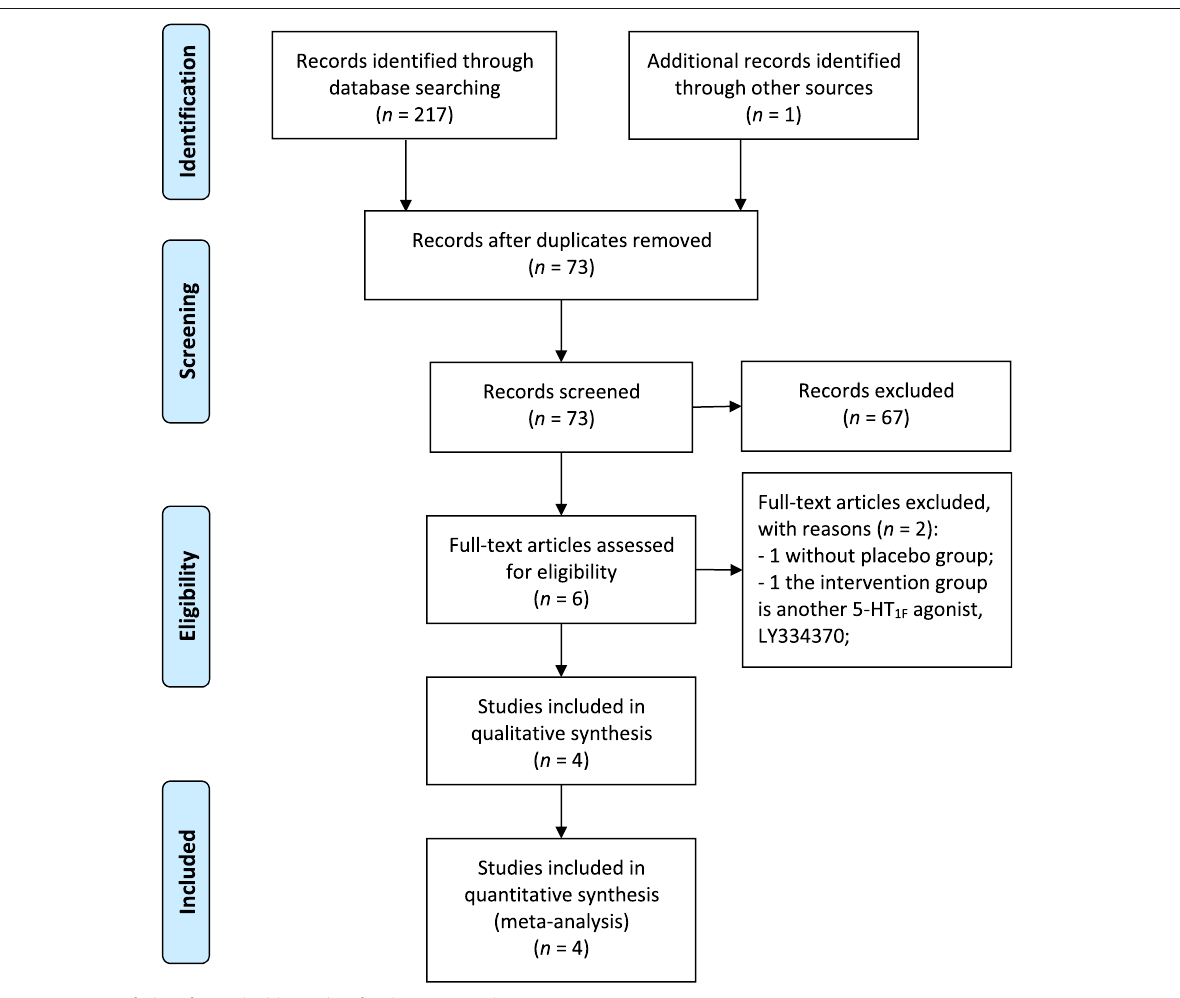
Fig. 1 Process of identifying eligible studies for the